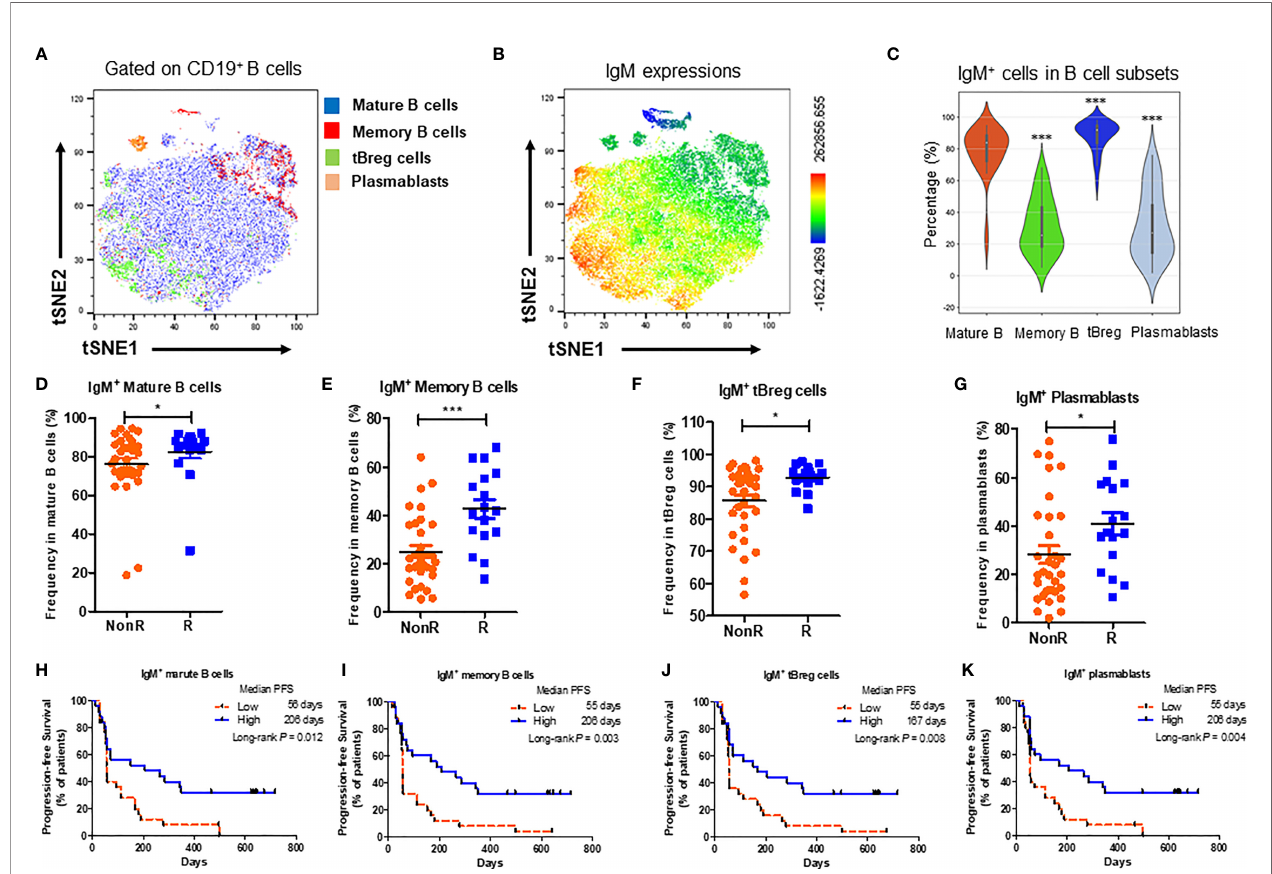
FIGURE 3 | High expressions of IgM on B cells subsets at the baseline are related to better responses to anti-PD-1 treatment. (A) Exempli fi ed t-distributed stochastic neighbor embedding (t-SNE) visualization of B cell subsets including mature B (CD24 + CD38 - CD19 + B), memory B (CD27 + CD19 + B), tBreg (CD24 + + CD38 + CD19 + B) and plasmablasts (CD24 - CD38 + CD19 + B) from 13 NSCLC patients. (B) IgM expressions on B cell subsets by t-SNE analysis. (C) Comparison of IgM expressions between mature B cells, memory B cells, tBreg cells and plasmablasts in NSCLC patients receiving anti-PD-1 therapy at the baseline (n = 50). (D – G) Comparison of the percentages of IgM + mature B cells (D) , IgM + memory B cells (E) , IgM + tBreg cells (F) and IgM + plasmablasts cells (G) between R (n = 17) and NonR (n = 33) NSCLC patients receiving anti-PD-1 monotherapy. (H – K) Kaplan-Meier analysis of associations of the percentages of IgM + mature B cells (H) , IgM + memory B cells (I) , IgM + tBreg cells (J) and IgM + plasmablasts cells (K) with the PFS values. The Wilcoxon test was used to analyze the differences between two groups. Survival curves were plotted by using the Kaplan-Meier method with the median as the cutoff value to de fi ne the high and low group. P -values were calculated by the log-rank statistics in Kaplan-Meier analyses. *** P < 0.001, * P < 0.05.